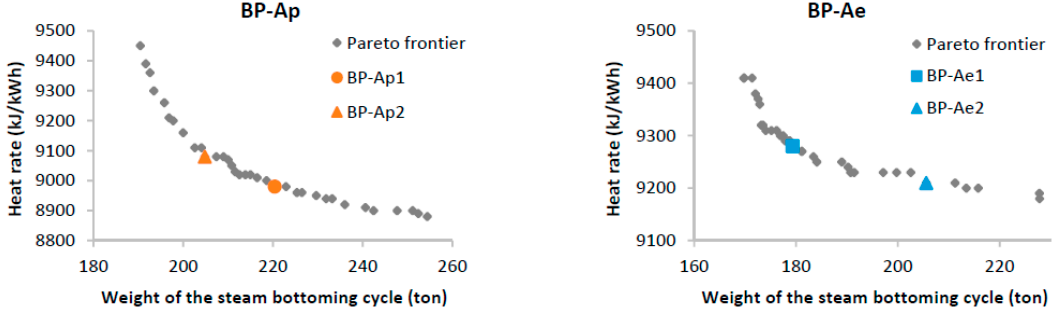
Figure A1. Pareto frontiers of backpressure steam turbine cycle for case A at peak (BP-Ap) and end-life (BP-Ae) conditions. Energies 2017 , 10 , 744